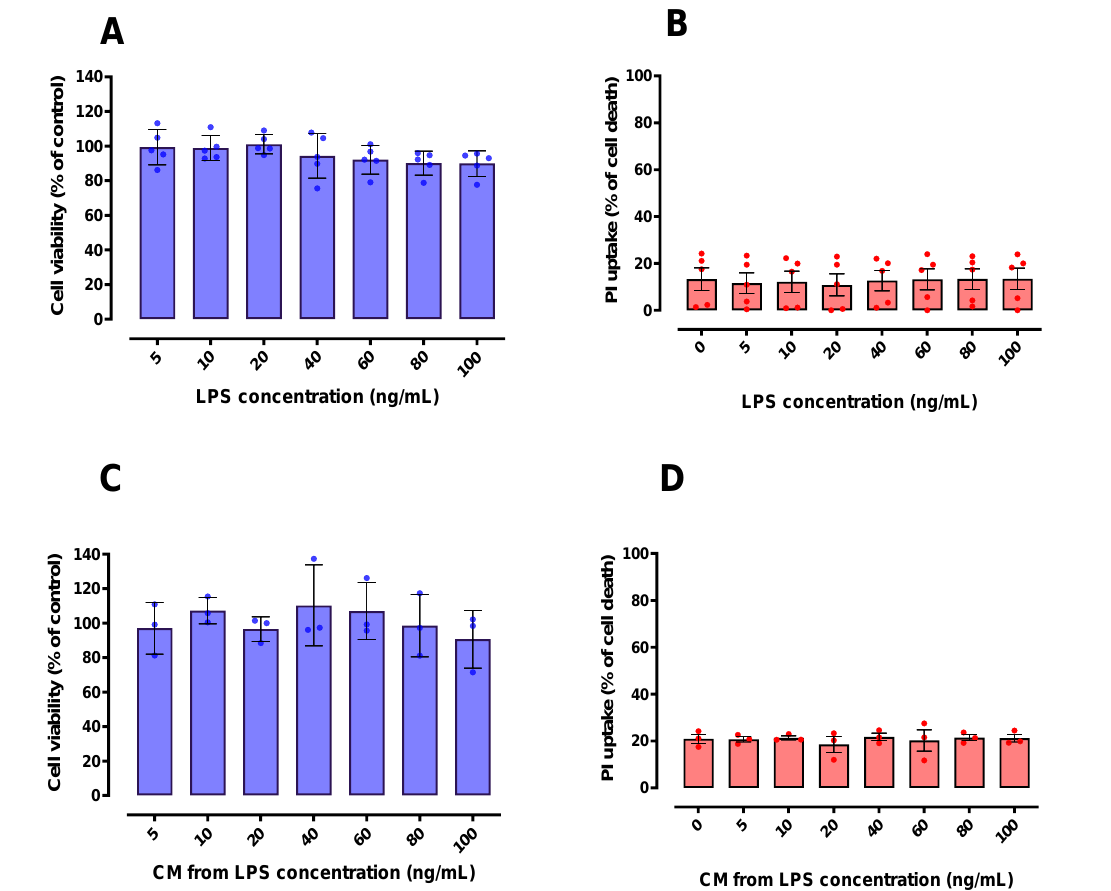
Figure 2. Effect of LPS and conditioned media (CM) on HT22 cell viability. Different concentrations of LPS ( A , B ) and CM produced by LPS-stimulated BV-2 cells ( C , D ) did not significantly affect cell viability of HT22 cells when compared to control group (untreated cells); 100% death: cells treated with 0.2% Triton X-100 for 20 min. n = 5 ( A , B ); n = 3 ( C , D